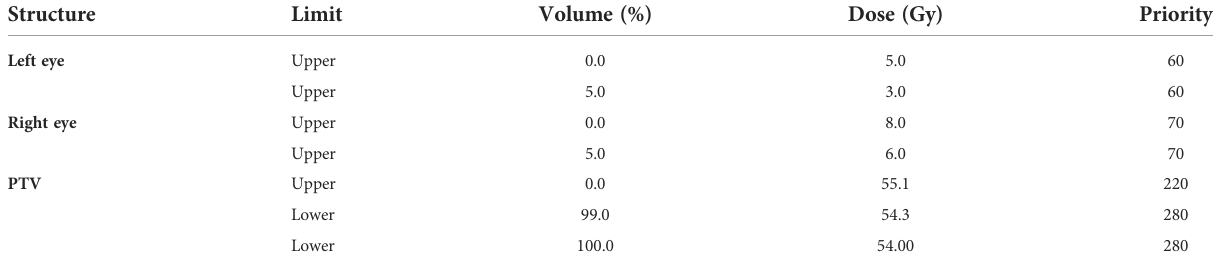
TABLE 3 Optimization objectives for inverse planning. Structure